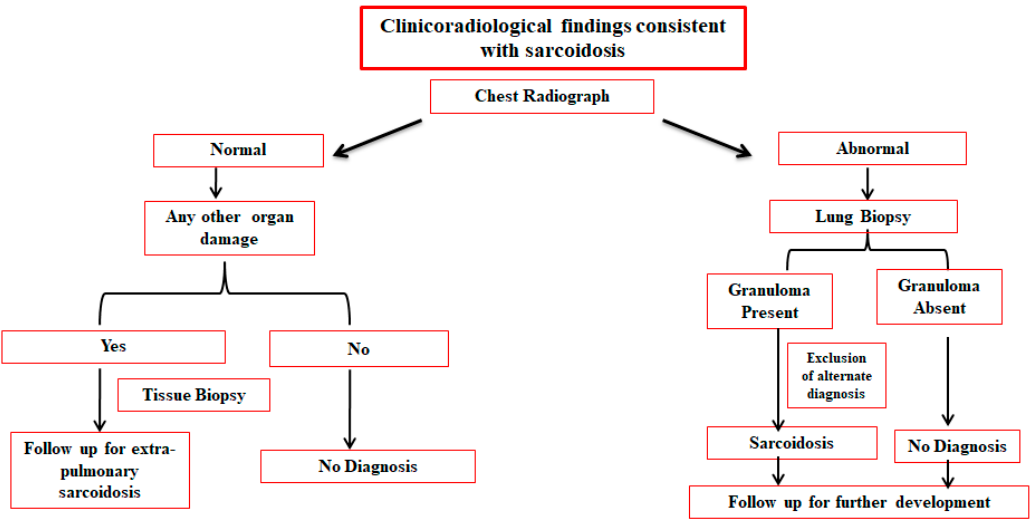
Figure 1. Diagnostic management of